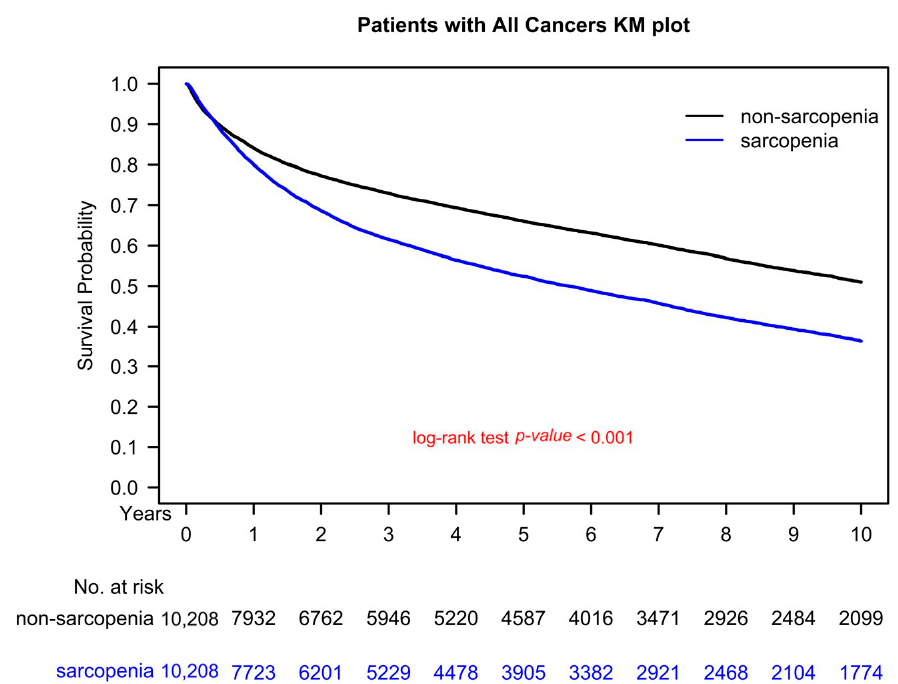
Figure 3. Kaplan–Meier overall survival curves for the propensity score–matched sarcopenia and nonsarcopenia groups (controls).